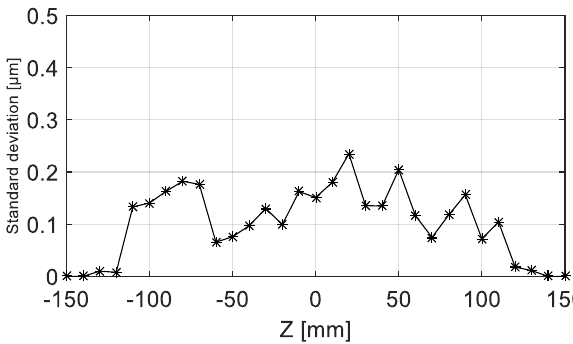
Figure 18. Planar tilted spraying: sample standard deviation of each measurement point.